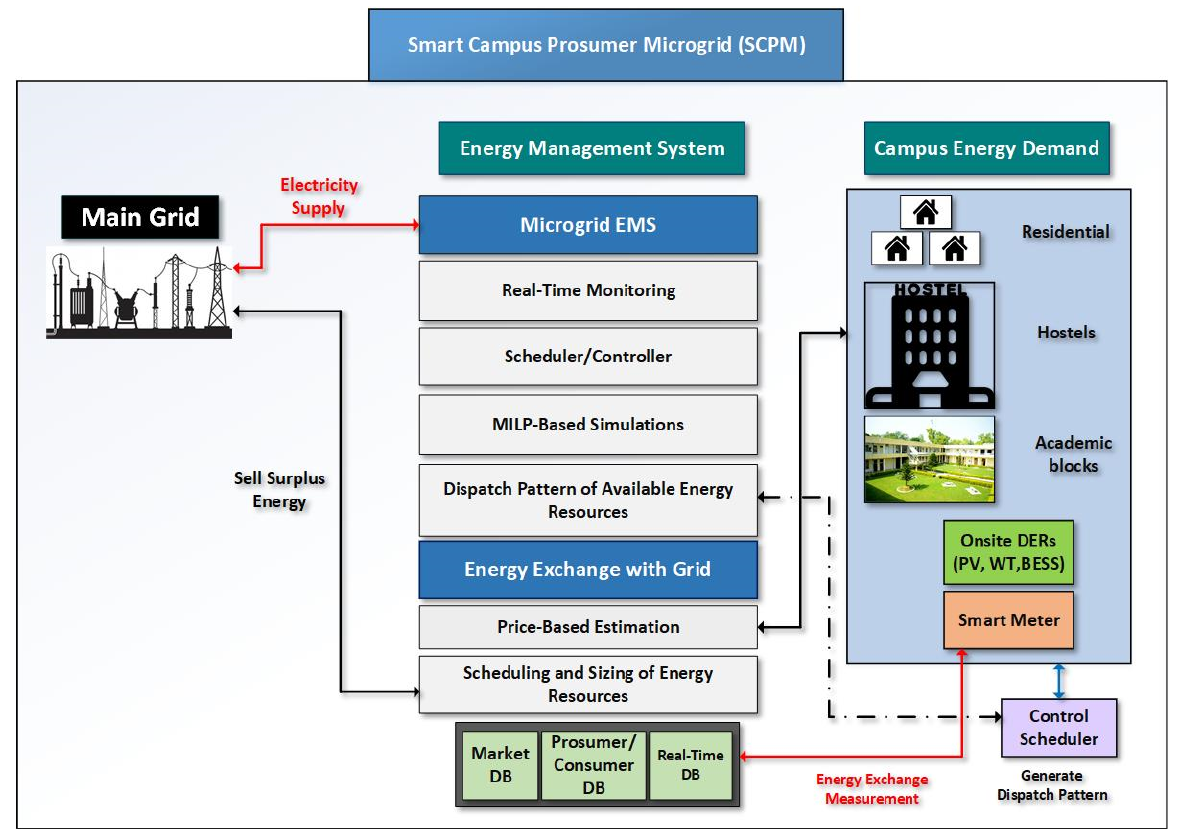
Figure 1. Proposed Conceptual model of EMS.